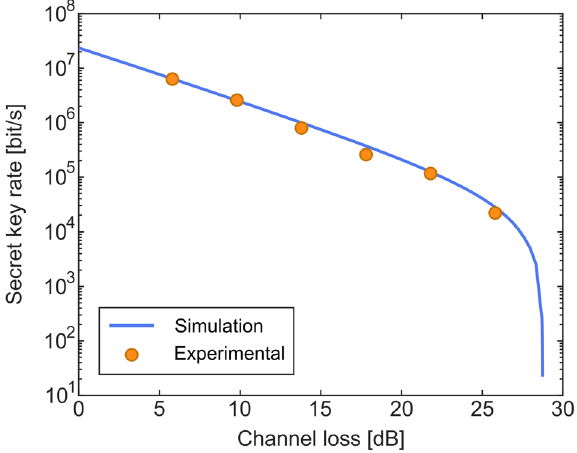
Fig. 5 Secret key rate. Simulation (solid line) of the secret key rate and values obtained from the experimental setup (orange points). Uncertainty values, computed as the standard error of the mean, are not displayed as error bars are covered by the